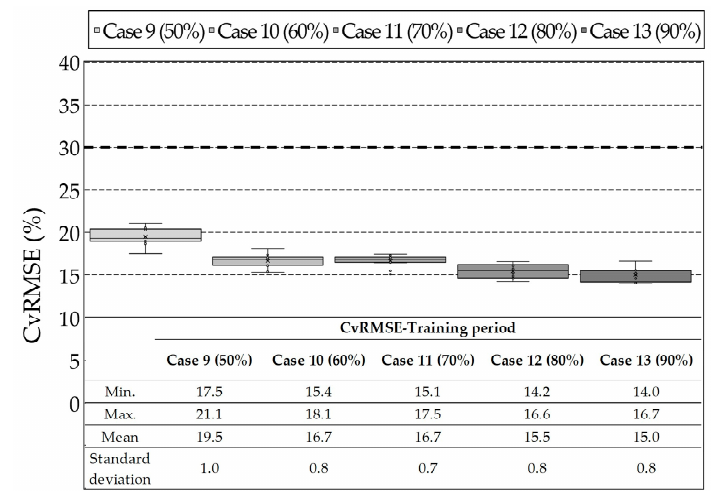
Figure 5. Accuracy according to changes in the proportion of training data for the training period.